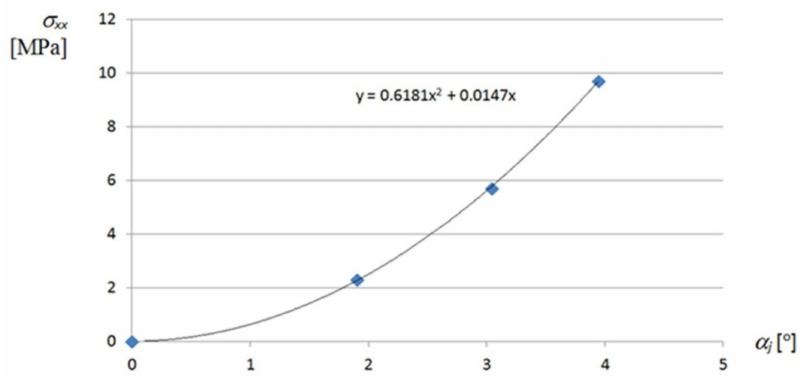
Figure A1. A non-linear relation between the σ xx normal stresses acting at the crosswise ends of an effectively twisted fold along the fold’s longitudinal axes and its α j unit